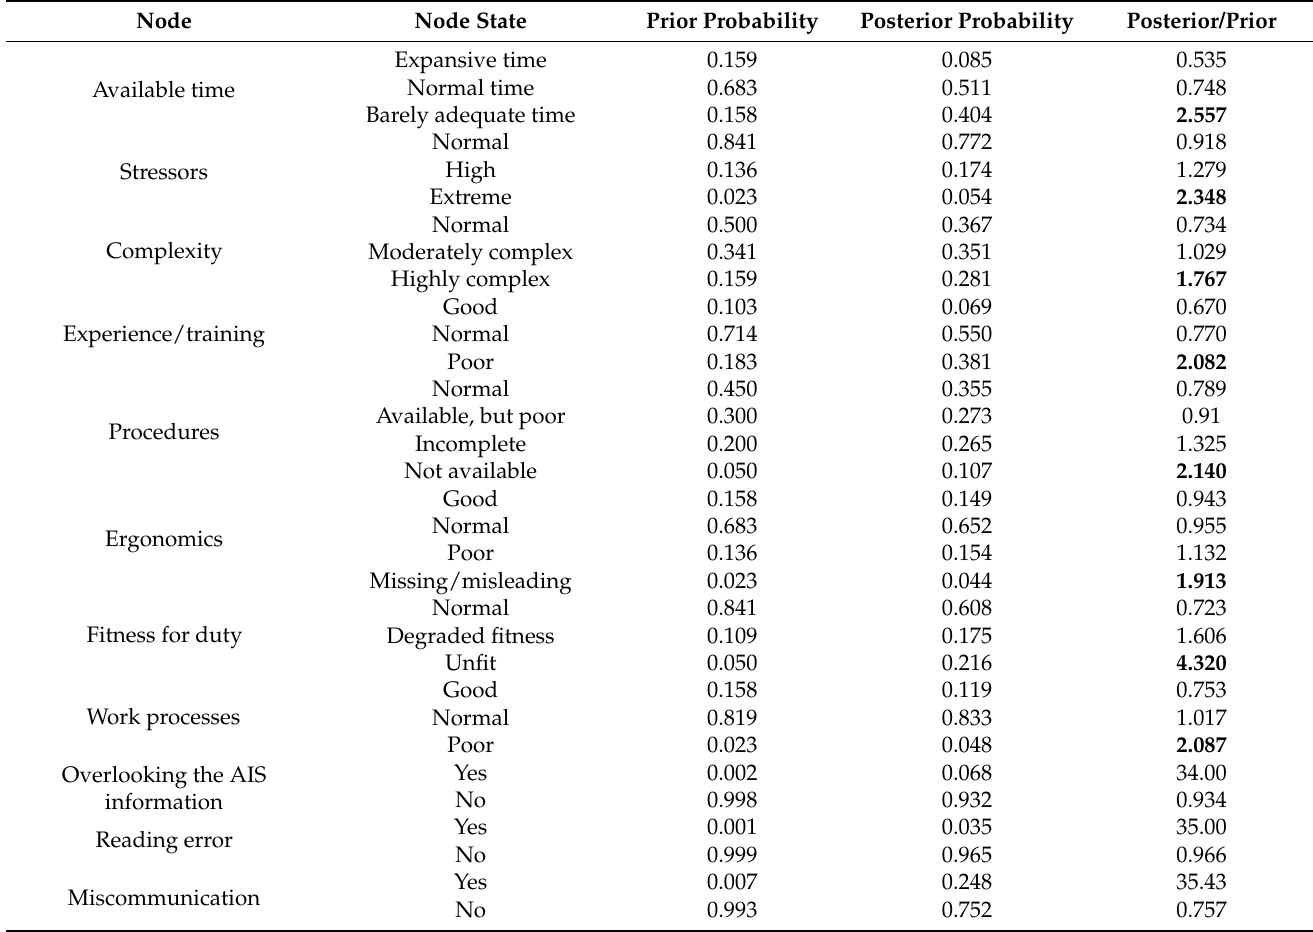
Table 4. Prior and posterior probability of every